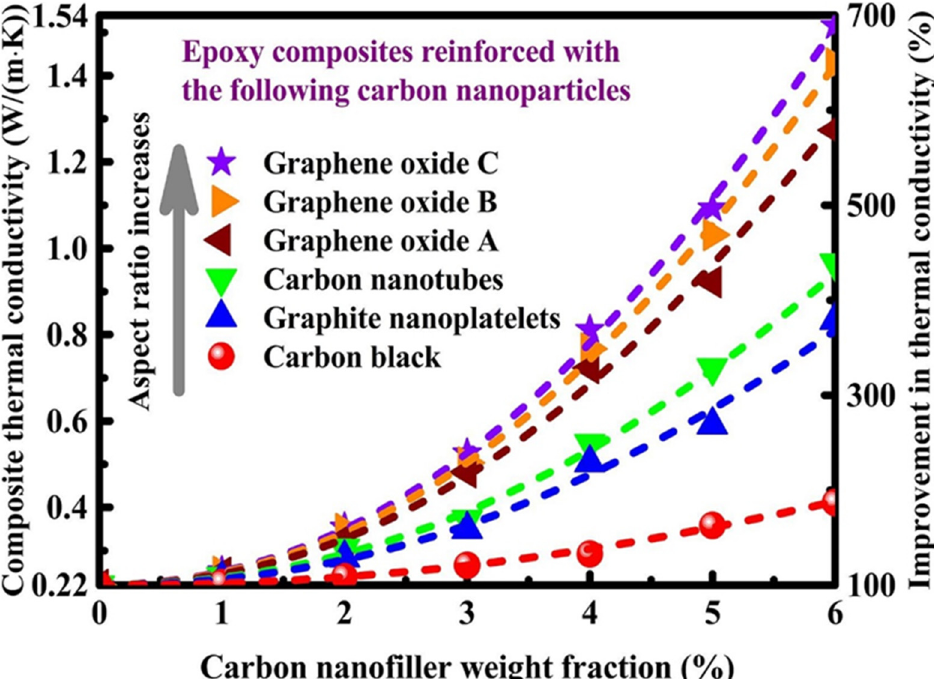
Figure 11. Thermal conductivity of carbon nano filler-based epoxy matrix composite materials at room temperature [129]. Table 3. Summary of the recently published works on carbon-based